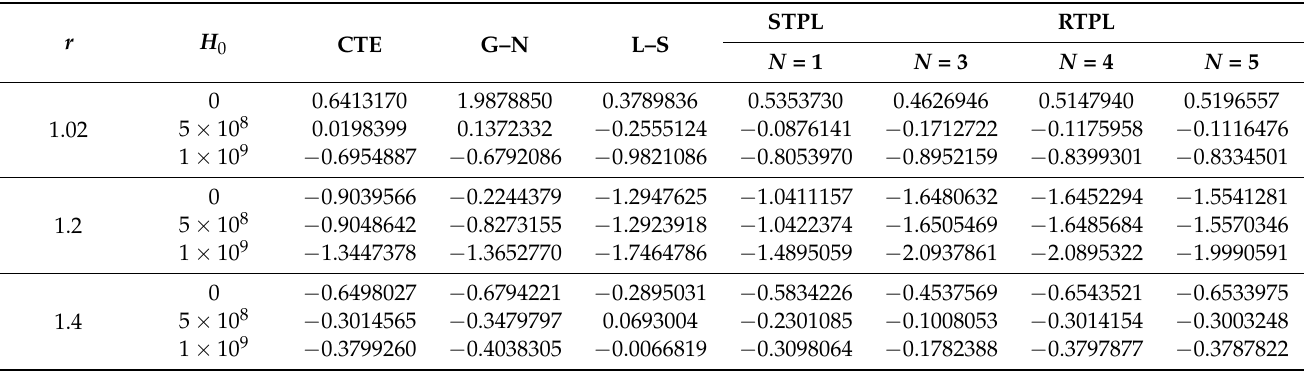
Table 10. Different thermoelasticity theories with a range of r values show the effects of dimensionless magnetic field intensity H 0 on circumferential stress σ ΘΘ